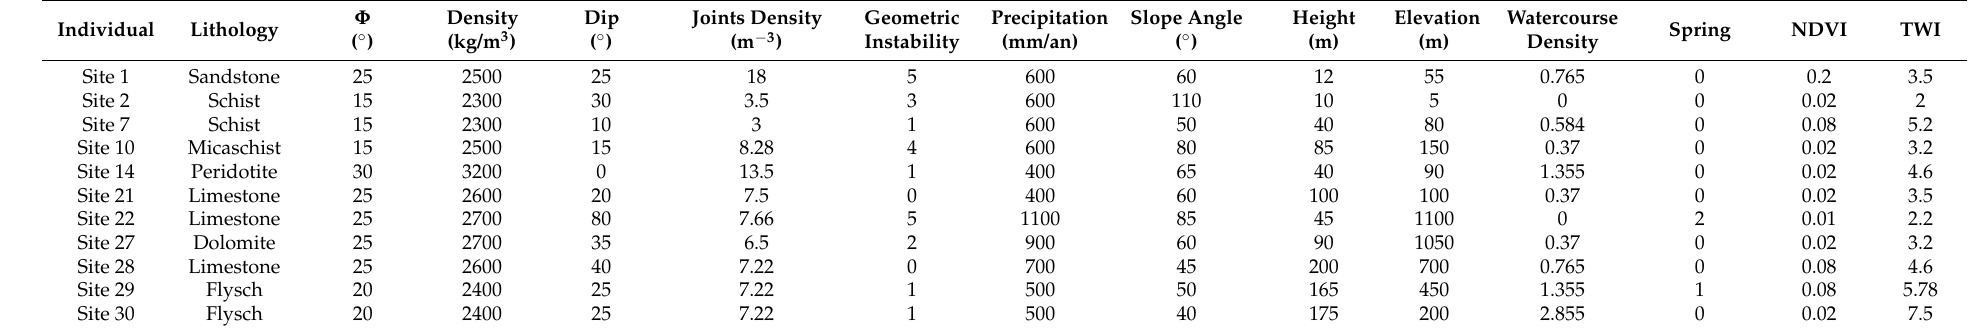
Table A3. PCA rockfall input data. See explanation of the abbreviations in Table